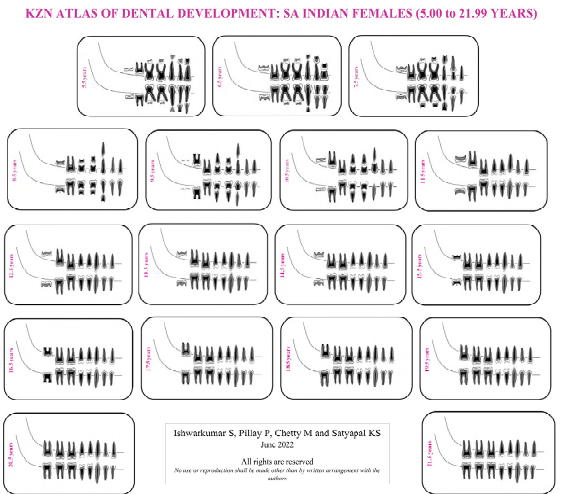
Figure 2. KZN Atlas of dental development for South African Black males.